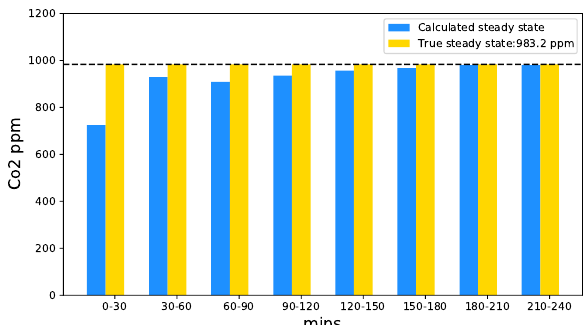
Figure 8. Steady-state prediction for CO 2